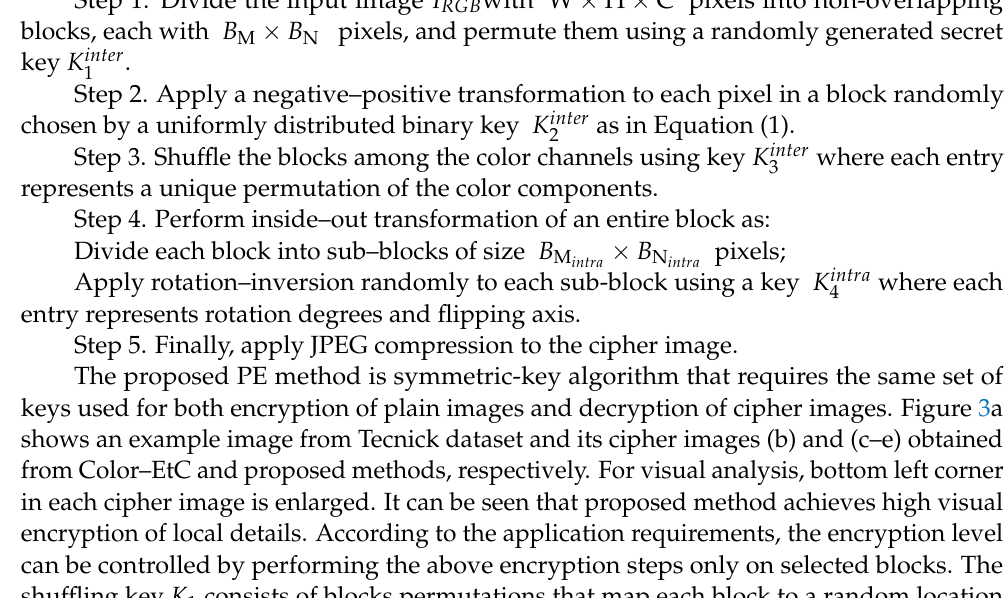
Figure 2. Comparison of existing and proposed perceptual encryption methods for color image encryption. The label of a block shows its original location while the dashed square inside a block shows its orientation. The negative–positive transformed blocks are the shaded ones. The color of a block border shows shuffled channels. The dotted line shows sub-block division.